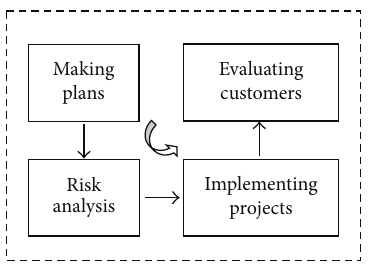
Figure 1: Multistage software development